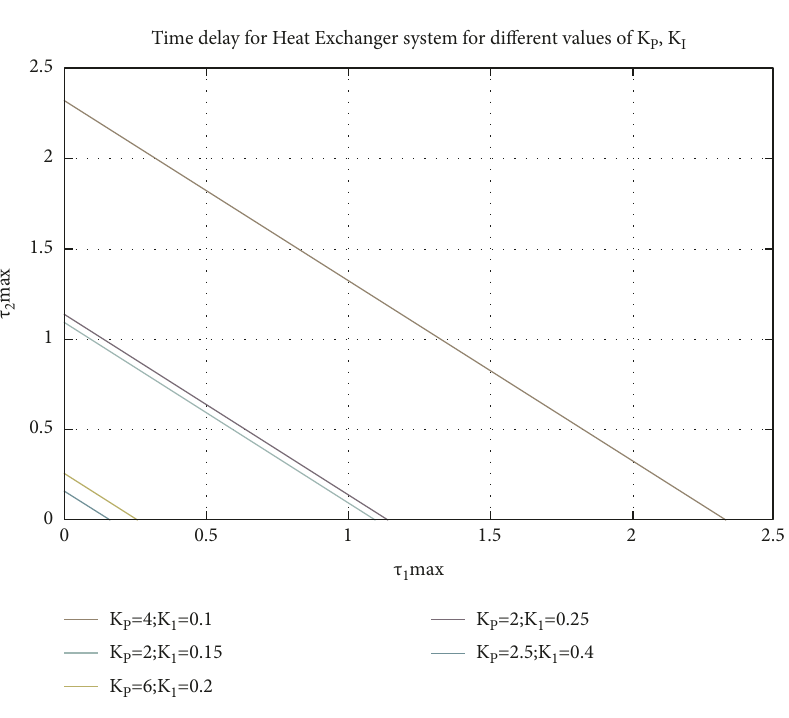
2 –5, the highest acceptable delay bound τ